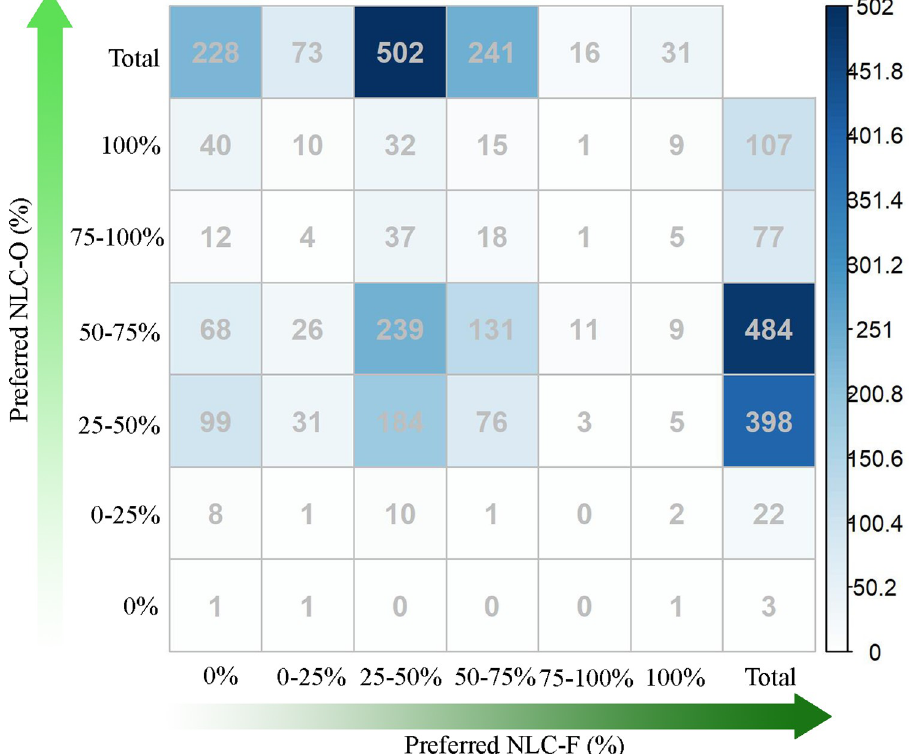
Fig 5. Preferred NLC-F and preferred NLC-O of native plant species. Preferred NLC-F and NLC-O were classified into six groups, corresponding to species with decreasing shapes (preferred NLC-F or NLC-O equalling 0%), species with increasing shapes (preferred NLC-F or NLC-O equalling 100%), species with preferred NLC-F or NLC-O between 0% and 25%, species with preferred NLC-F or NLC-O ranging from 25% to 50%, species with preferred NLC-F or NLC-O ranging from 50% to 75%, species with preferred NLC-F or NLC-O ranging from 75% to 100%. The number of species (in each grid) increases with the blue color in each grid getting dark.